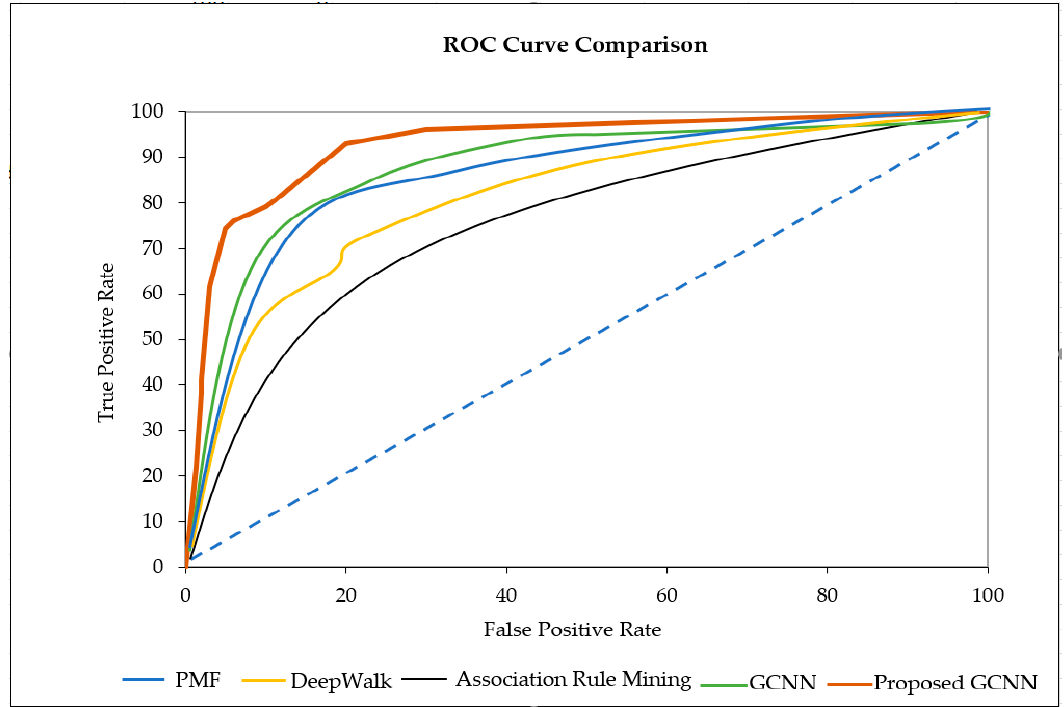
Figure 14. Receiver operating characteristic curve (ROC) comparison.